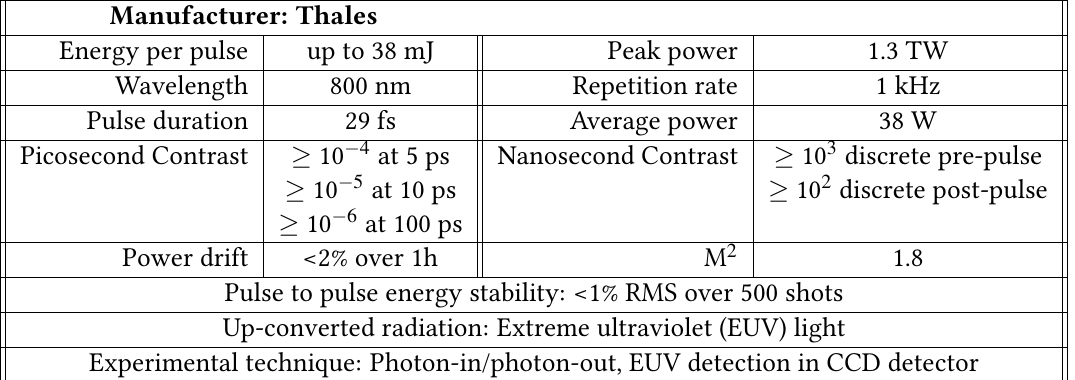
Table 1: Main output parameters of laser system for generation of high energy photons and electron